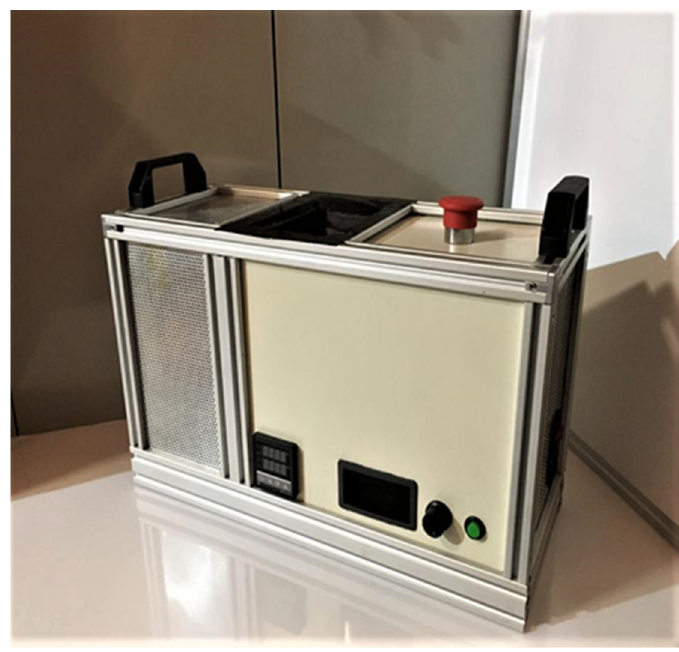
Figure 2. The obtained horizontal hot ‐ melt extruder.